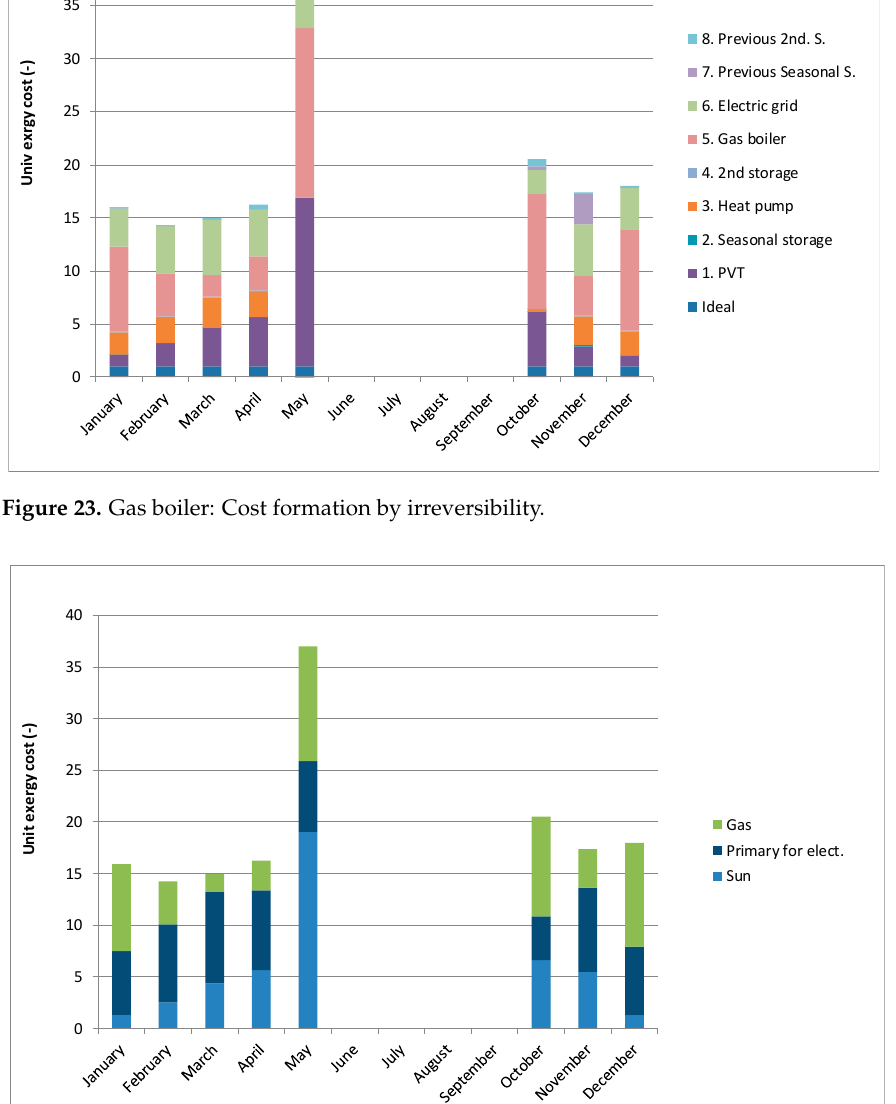
Figure 24. Gas boiler: Cost formation by source.